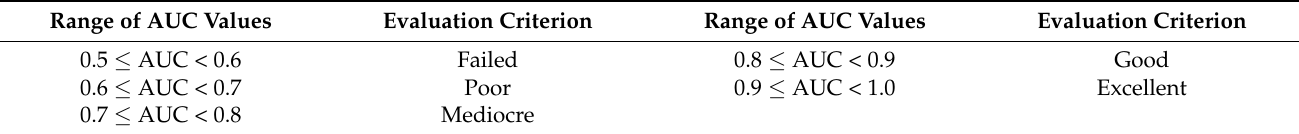
Table 2. The evaluation criterion of AUC.